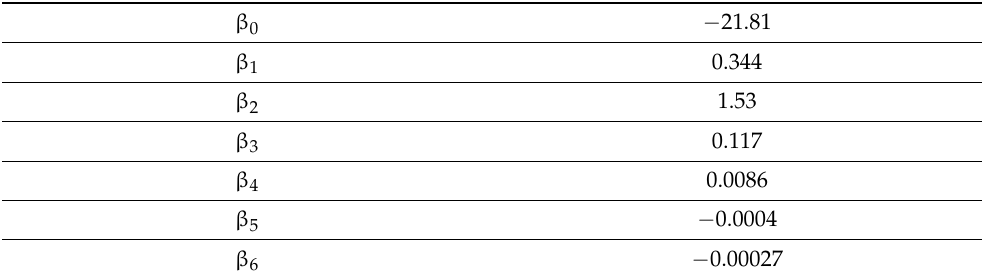
Table 2. The values of the regression model coefficients. β 0